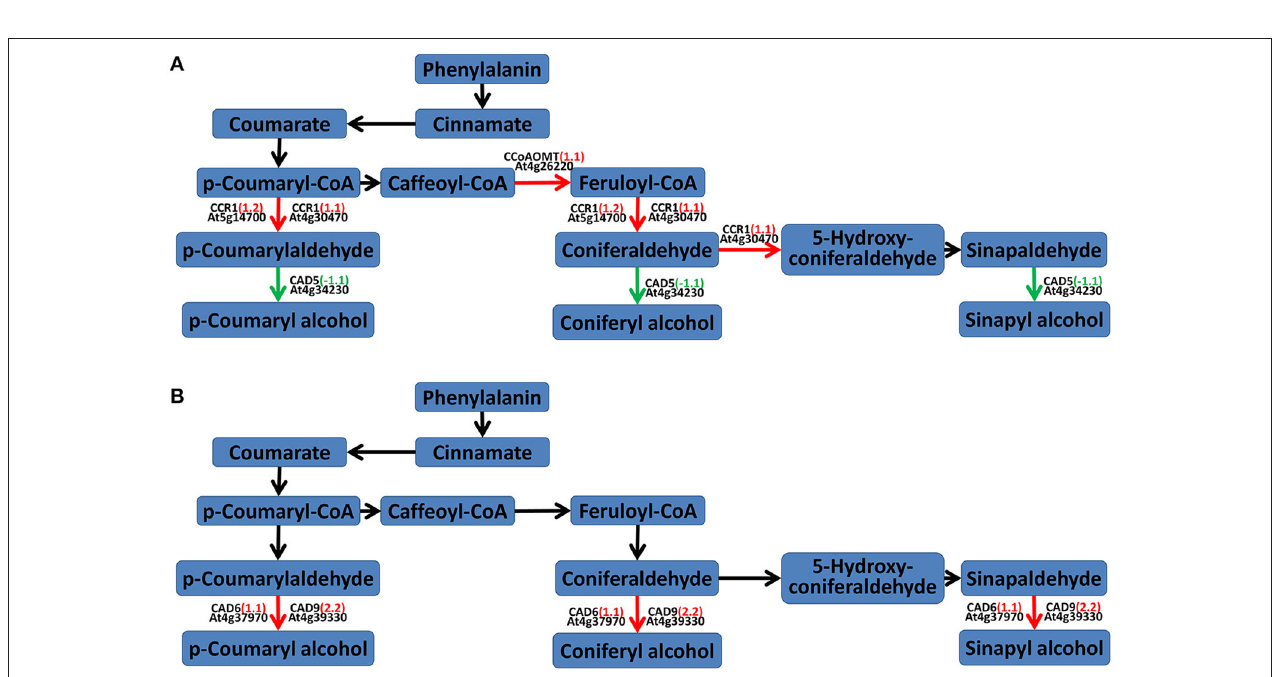
FIGURE 7 | Lignin pathway analyses of DEGs in A. thaliana during early infection by P. brassicae. Analysis of the lignin (phenylpropanoid biosynthesis) pathway of DEGs was performed using MAPMAN software. Red arrows mean up-regulated genes and green mean down-regulated. Black ones mean no change. (A) 24 h after inoculation; (B) 48 h after inoculation. The pathway frames are from the MAPMAN software